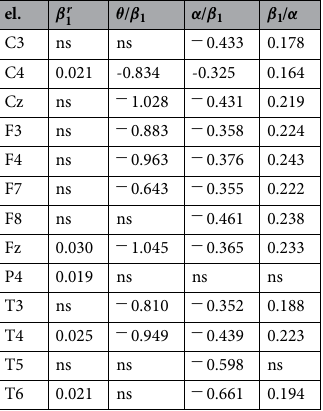
Table 1. Differences between the mean values of the control group and the mean values of the FASD group. Note, that only statistically significant differences were included; ns stands for